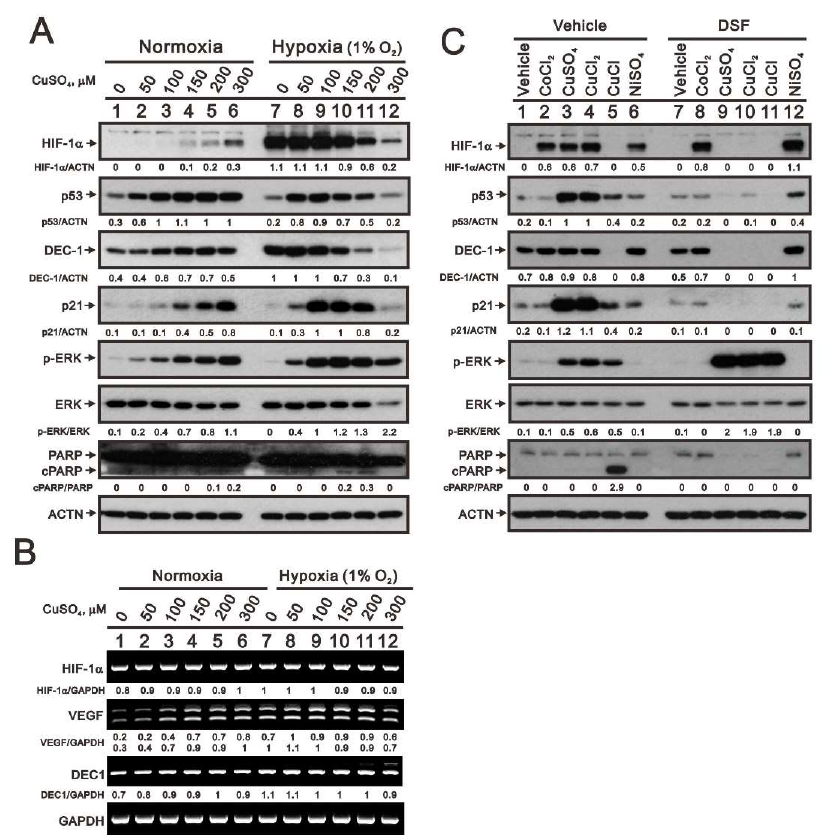
Figure 5. E ff ects of copper sulfate on expression of HIF-1 α in normoxic and hypoxic HeLa cells. ( A , B ) HeLa cells were incubated for 6 h with the indicated concentrations of copper sulfate under normoxia and hypoxia (1% O 2 ). ( A ) Cell lysates were subjected to western blot analysis using antibodies against HIF-1 α , p53, DEC1, p21, total and phosphorylated (p)-ERK, and total and cPARP. ( B ) RT-PCR analysis for HIF-1 α , VEGF , and DEC1 . ACTN was the protein loading control; GAPDH mRNA was the mRNA loading control. ( C ) HeLa cells were incubated for 8 h with the indicated compounds (300 µ M), after which cell lysates were subjected to western blot analysis using antibodies against HIF-1 α , p53, DEC1, p21, total and p-ERK, and total and cleaved PARP. ACTN was the protein loading control. The results are representative of three independent experiments. Protein and PCR bands were quantified through pixel density scanning and evaluated using ImageJ, version 1.44a (http: // imagej.nih.gov / ij / ). The fold (shown above the bands) was normalized to the internal control protein (ACTN) or gene ( GAPDH ). Phosphorylated ERK after normalization to total ERK protein and cPARP fragment after normalization to full-length PARP protein are shown as fold